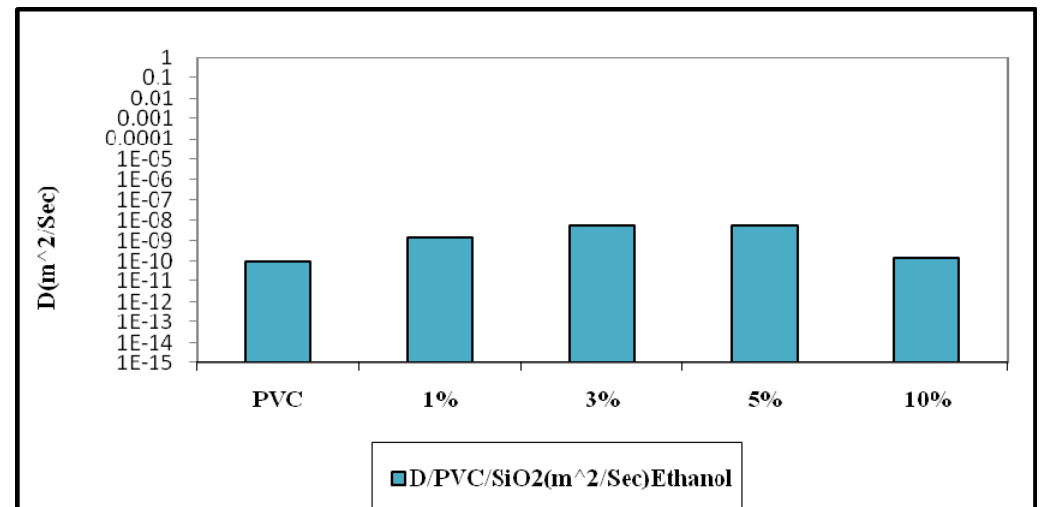
/PVC composites. 2